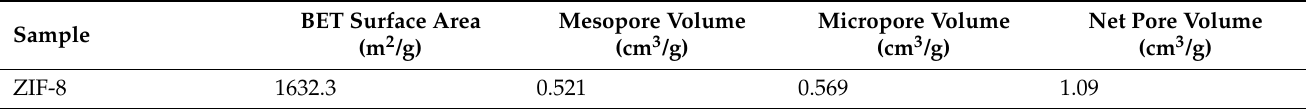
Figure 6. Nitrogen adsorption isotherm of ZIF-8 nanoparticles. Table 1. The pore textural properties of virgin ZIF-8.